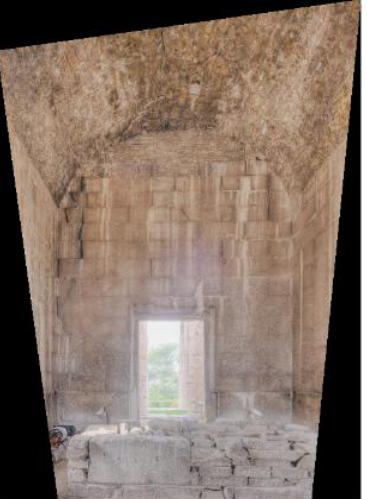
Figure 8: Final georefenced image through rectification